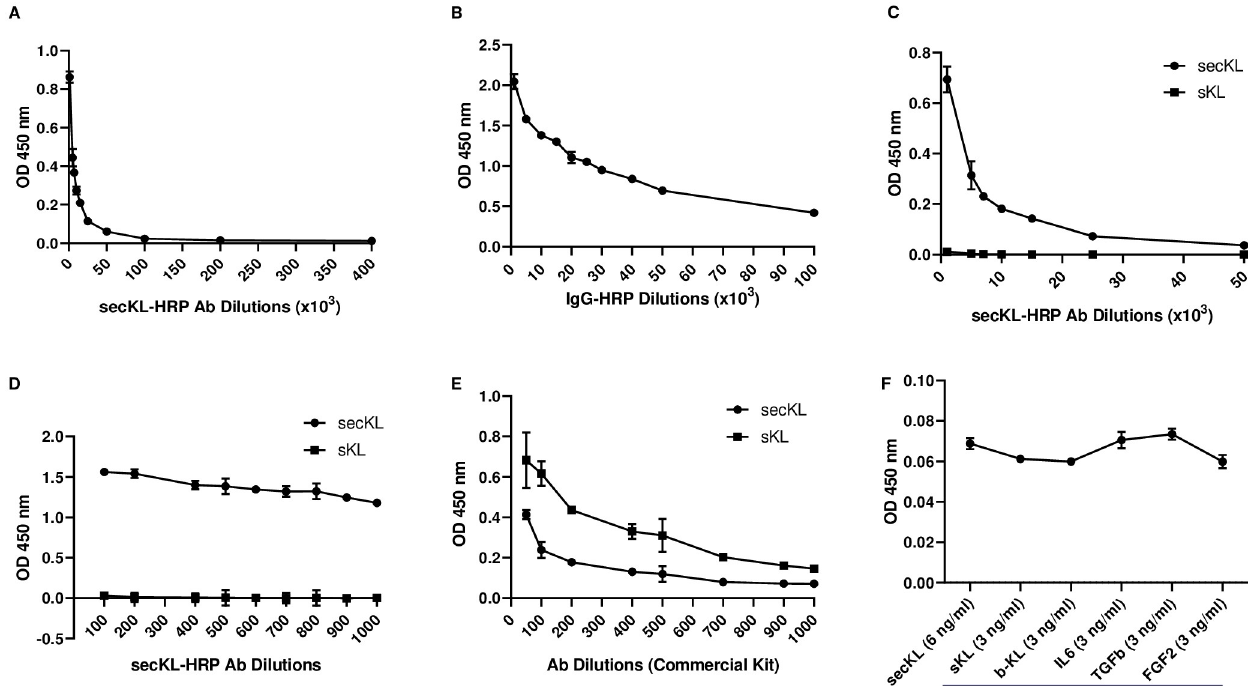
Fig 1. High specificity of secKL antibody for secKL protein. (A) secKL Ab detects rsecKL protein in a direct ELISA setting over a high dilution range: 1:1000, 1:5000, 1:7000, 1:10000, 1:25000, 1:50000, 1:100000, 1:200000, 1:400000 (B) secKL Ab detects rsecKL protein in an indirect ELISA setting via HRP labelled secondary Ab (IgG dilutions: 1:1000, 1:5000, 1:10000, 1:15000, 1:20000, 1:25000, 1:30000, 1:40000, 1:50000, 1:100000) (C) secKL Ab can detect rsecKL but not rsKL protein in a direct ELISA setting at a higher dilution range (Ab dilutions: 1:1000, 1:5000, 1:7000, 1:10000, 1:15000, 1:25000, 1:50000) (D) secKL Ab can detect rsecKL but not rsKL protein in a direct ELISA setting at a lower dilution range (Ab dilutions: 1:100, 1:200, 1:400, 1:500, 1:600, 1:700, 1:800, 1:900, 1:1000) (E) Labelled detection antibody from IBL kit can detect both, rsKL and rsecKL proteins in a direct ELISA setting (Ab dilutions: 1:50, 1:100, 1:200, 1:400, 1:500, 1:700, 1:900, 1:1000) (F) secKL Ab can specifically detect rsecKL protein (6ng/ml) in the presence of indicated spiked-in non-specific proteins